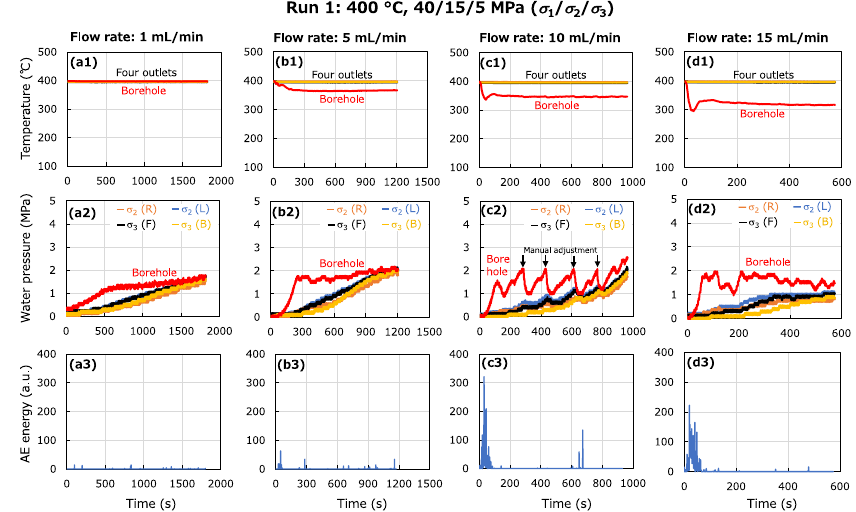
Fig. 4 Temporal changes in temperatures and water pressures for the borehole and four outlet faces, and AE energy at 1 mL/min (a1–a3), 5 mL/min (b1–b3), 10 mL/min (c1–c3), and 15 mL/min (d1–d3) in Run 1. σ x (y) in the middle row demotes the pressure for the outlet face, y (R: right face, L: left face, F: front face, B: back